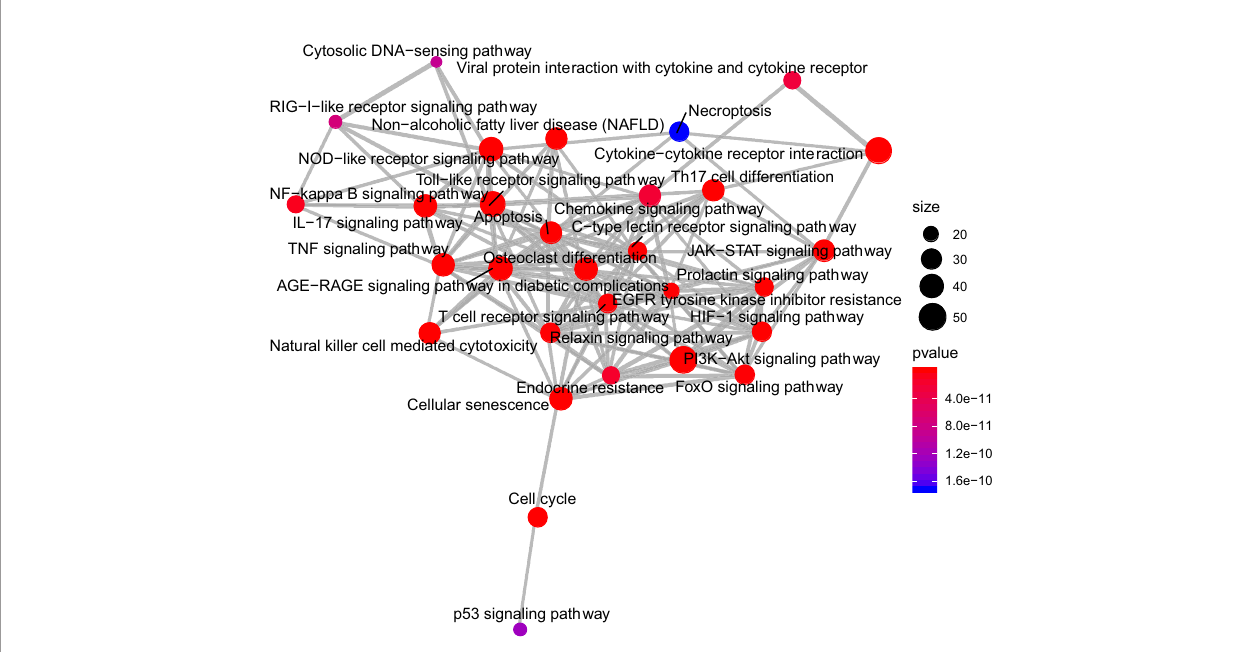
FIGURE 6 | The network of pathway enrichment analysis through KEGG. The size of the node represents the number of genes involved in the enrichment pathway, and the color from blue to red indicates the P-value from small to